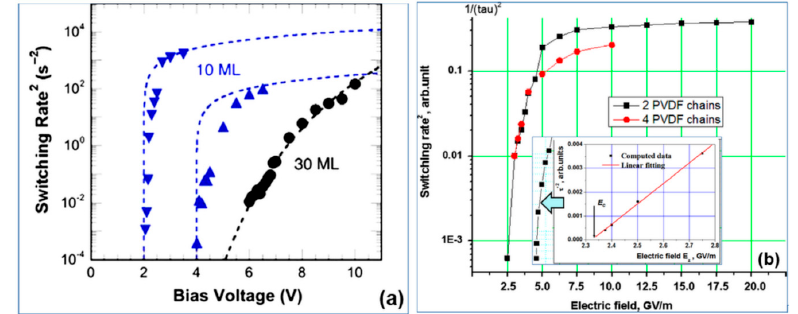
Figure 3. Switching time τ s for polymer ferroelectrics presented as τ − 2 along E in a logarithmic scale: ( a ) experimental data [14,15] for thin LB of P(VDF-TrFE) film of 10 ML (5 nm) with critical behavior of τ − 2 for E → E C in comparison with thick 30 ML (15 nm) films with exponential low (Reproduced with permission from [14]; AIP Publishing, 2011); ( b ) MD simulation run data [18,19] for PVDF models showing the critical behavior of τ − 2 with a change in E, which qualitatively coincides with the experimentally observed behavior; the inset shows the linear behavior of τ − 2 as E → E C and determines the critical value of E C ~ 2.3 GV/m (Reproduced with permission from [18]; Elsevier, 2014). The critical behavior of τ − 2 for E → E C for the P(VDF-TrFE) LB films was shown in [14,15] (see Figure 3a). Figure 3a presents the data measured for a film of 10 ML (5 nm). Dotted lines show theoretical points corresponding to Equation (7), and triangles show experimental data. For a thicker film of 30 ML (15 nm), the circles indicate the experimental values of τ − 2 , and the dotted line indicates the exponential dependence. Figure 3b shows the calculated data using the MD run for τ − 2 ( E ) behavior in a similar logarithmic scale, which qualitatively coincides with the experimentally